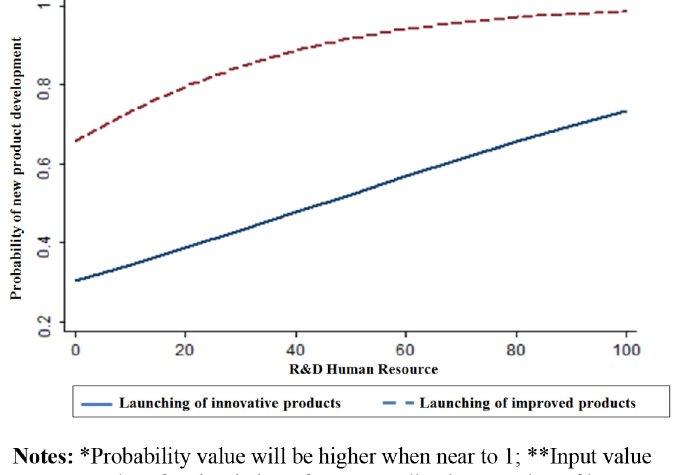
Figure 3. Simulation